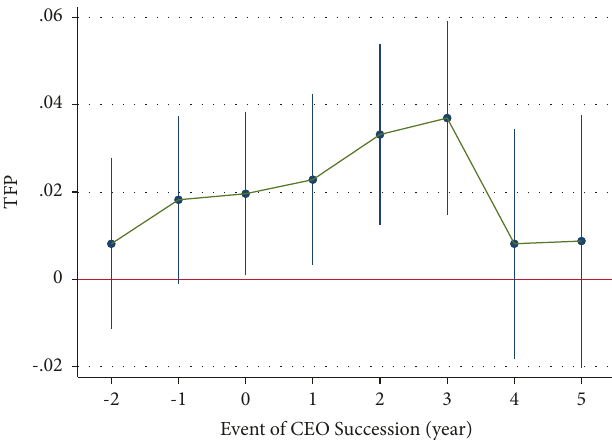
Figure 2: Event study analysis of experienced CEO succession. Table 4: Coefficient of the placebo